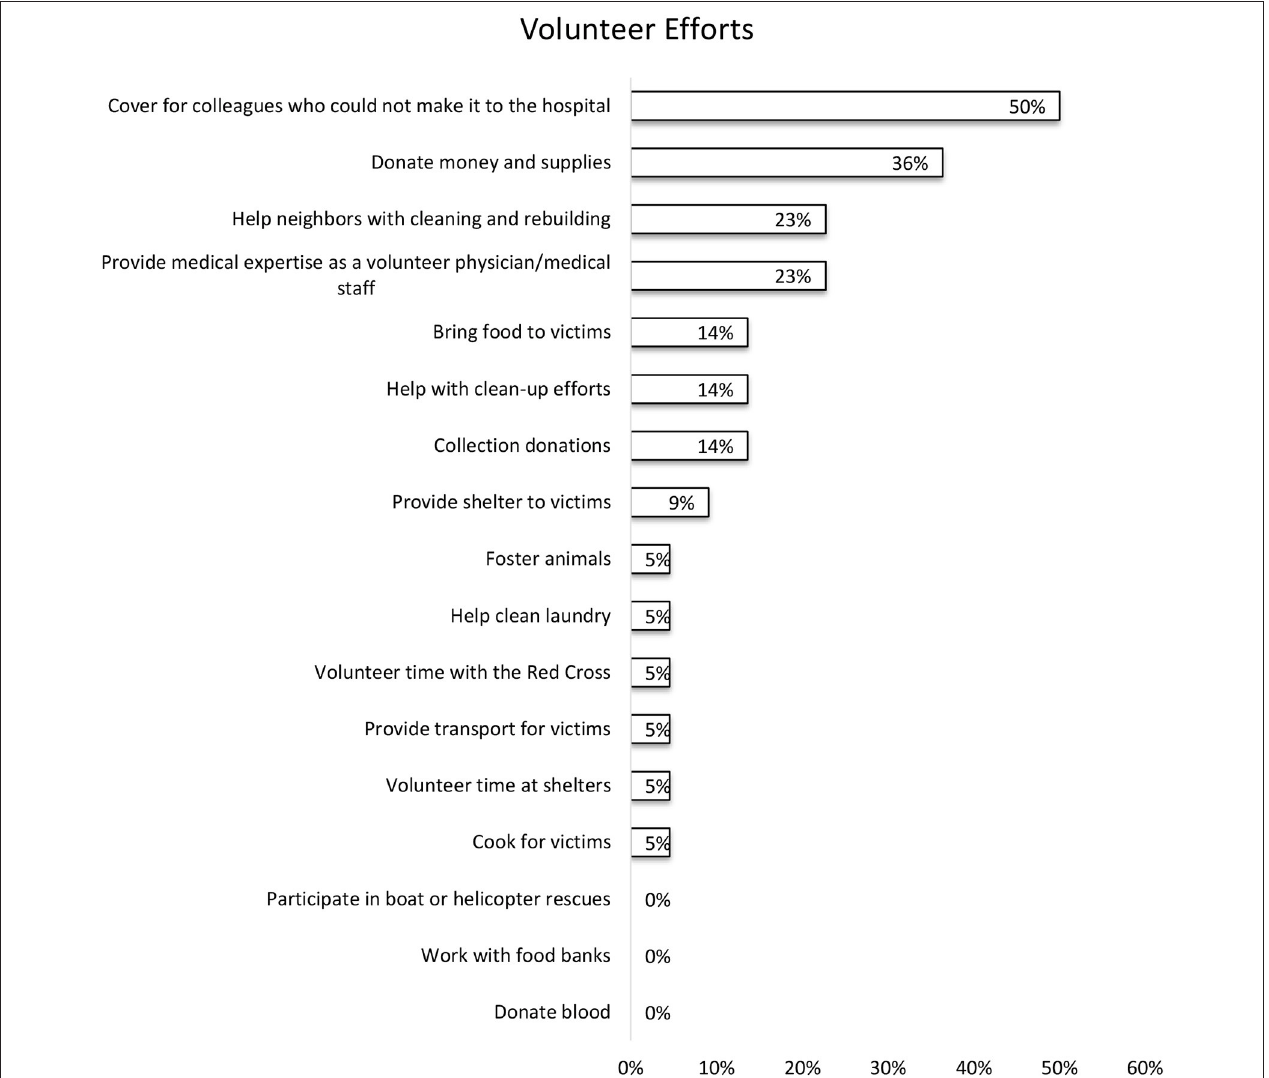
FIGURE 3 | Types of volunteer activities the trainees participated in. The survey responders were able to choose any and all activities which they participated in.